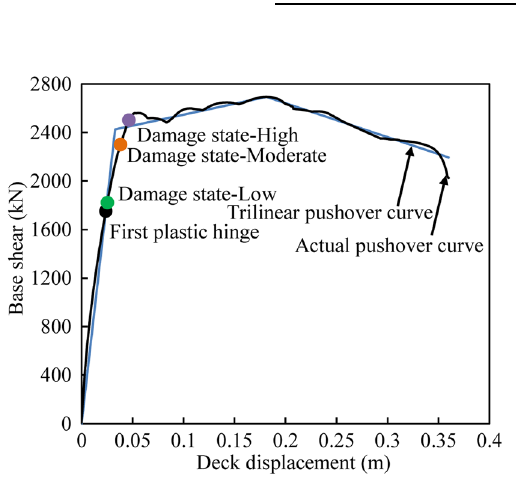
Fig. 10 Pushover curve for case study II